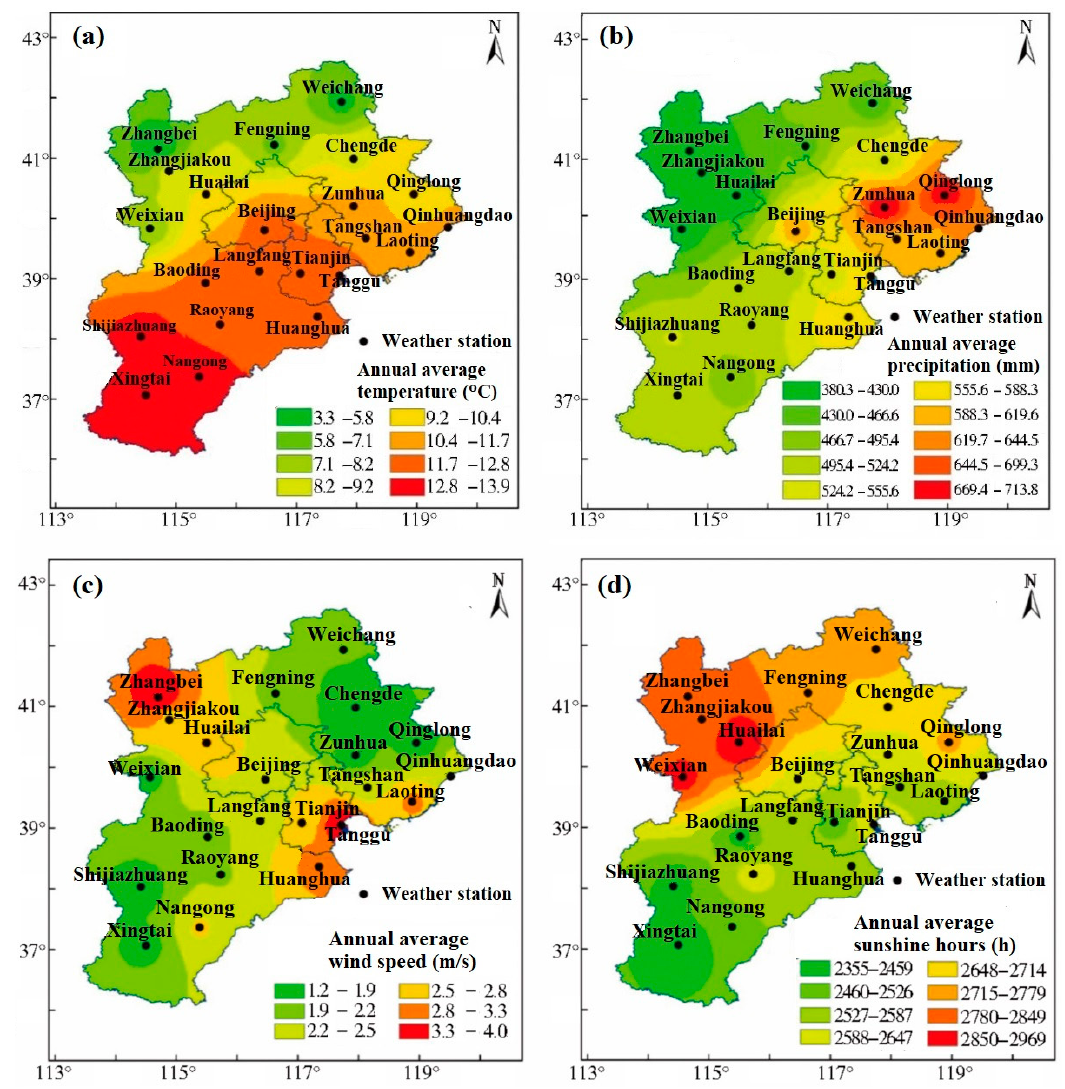
Figure 2. the spatial distribution of climatic variables (temperature ( a ), precipitation ( b ), wind speed ( c ) and sunlight ( d )) over the Beijing–Tianjin–Hebei region between 2003 and 2020.